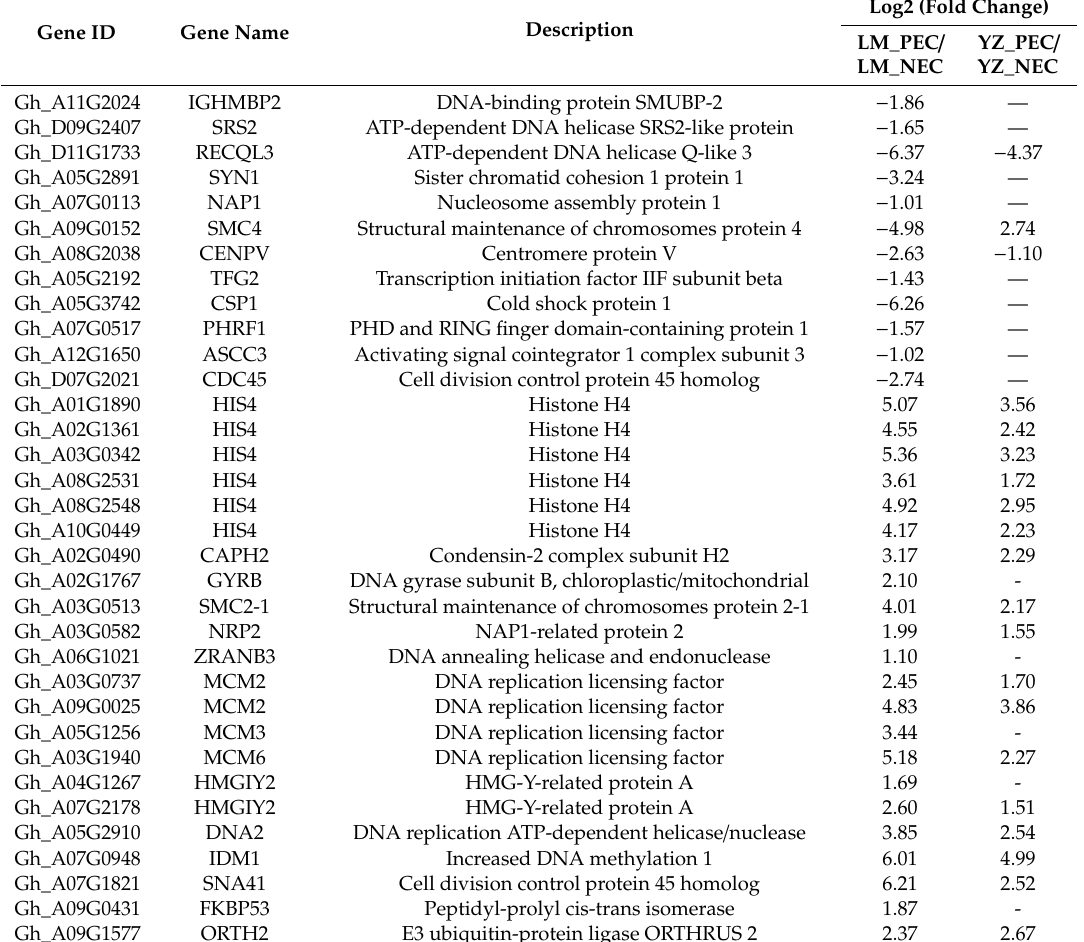
Table 1. Significantly representative SE-related DEGs enriched in DNA conformation change process during embryogenic transdi ff